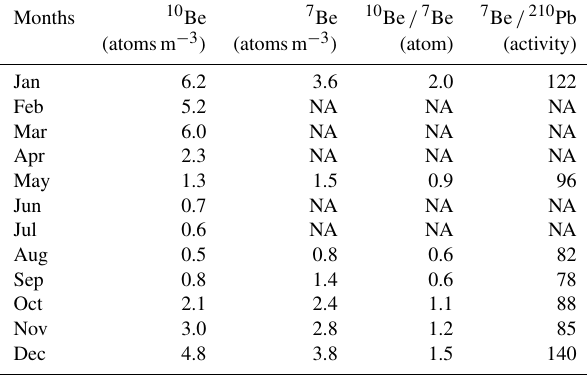
Table 3. Monthly data of atmospheric 10 Be and 7 Be at Concordia along with tracers of arrival of stratospheric aerosols ( 10 Be / 7 Be as atom ratio and 7 Be / 210 Pb as activity ratio).